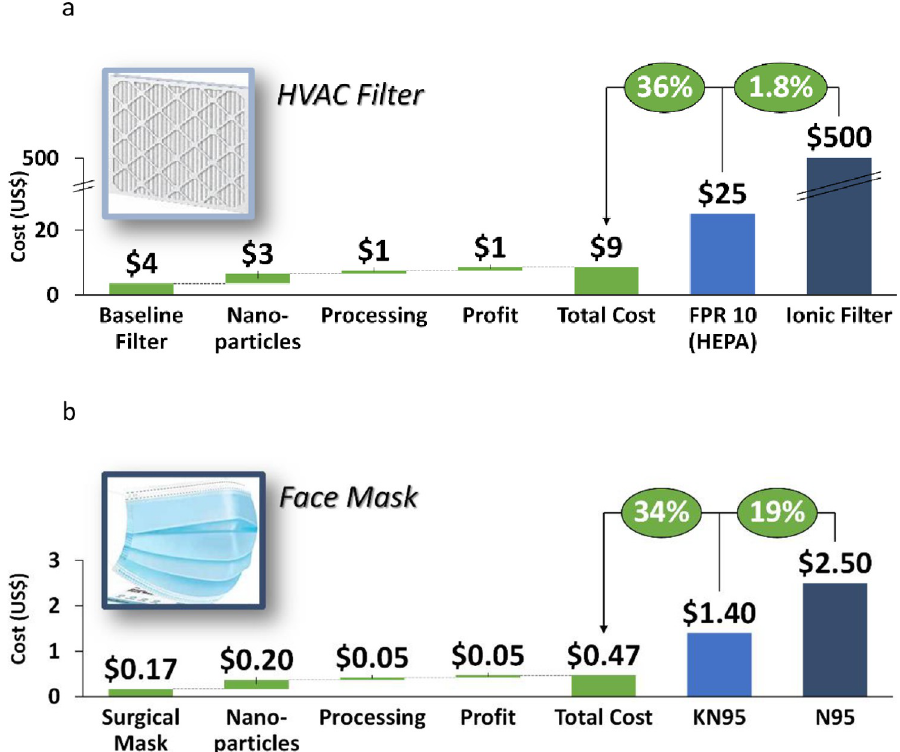
Fig 14. a. Nanoparticle coated HVAC filters are ~2% of the cost of an ionic filtration system and ~36% of the cost of a HEPA (FPR 10) HVAC filter. b. Nanoparticle coated surgical masks are ~19% of the cost of an N95 mask and ~34% of the cost of a KN95